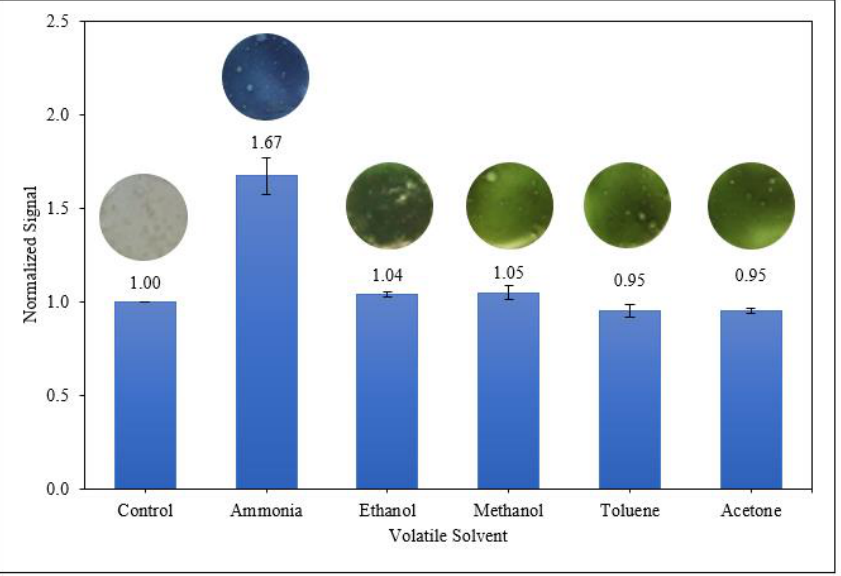
Figure 13. Colourimetric response of starch/PANI 0.4% film towards various volatile vapours.